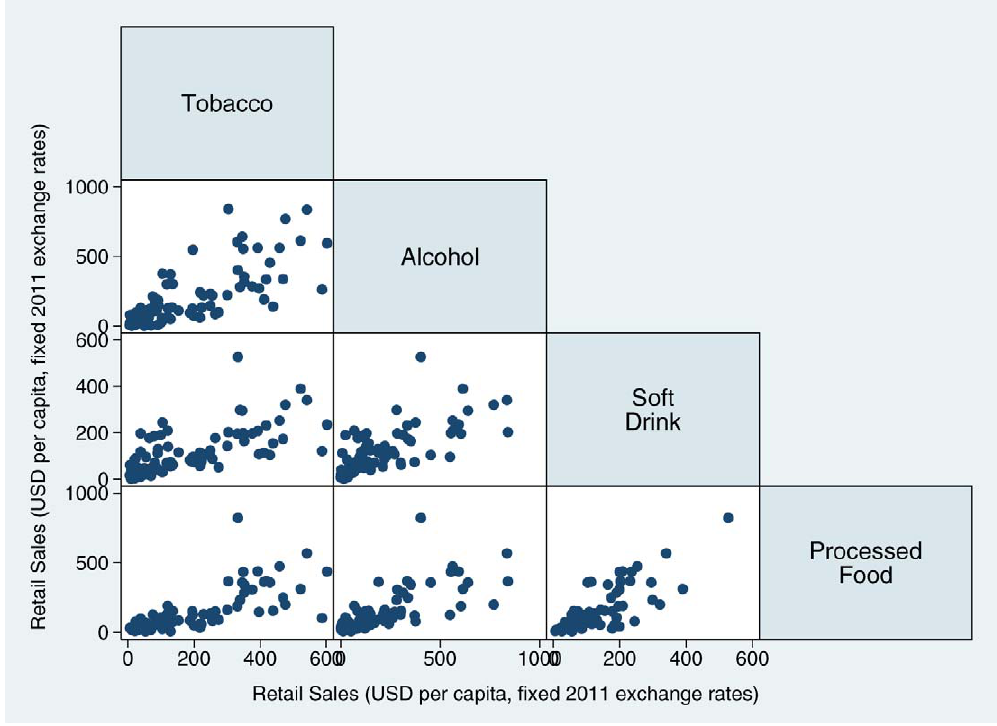
Figure 2. Associations of tobacco, alcohol, soft drink and processed food markets, 80 countries, 2010.